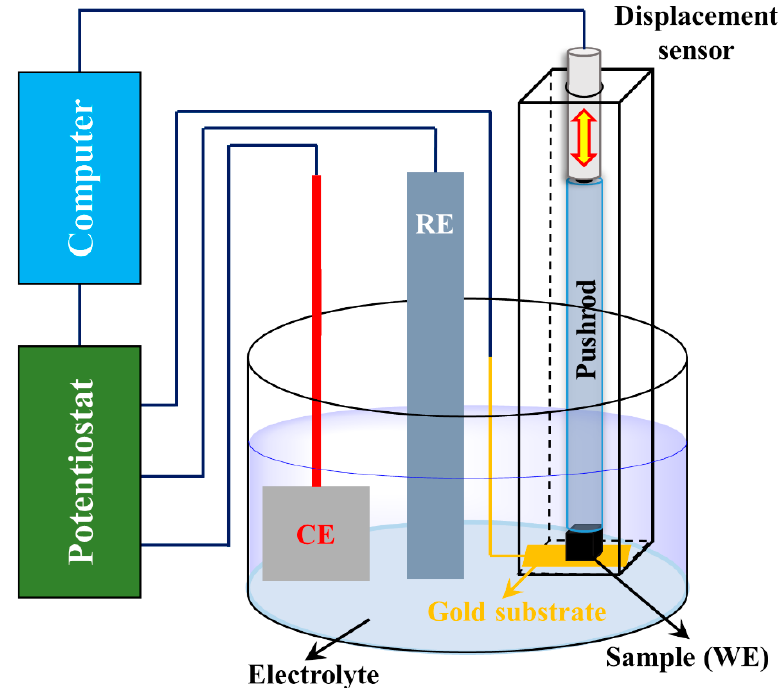
Figure 1. Schematic illustration of the actuation device with three electrodes.